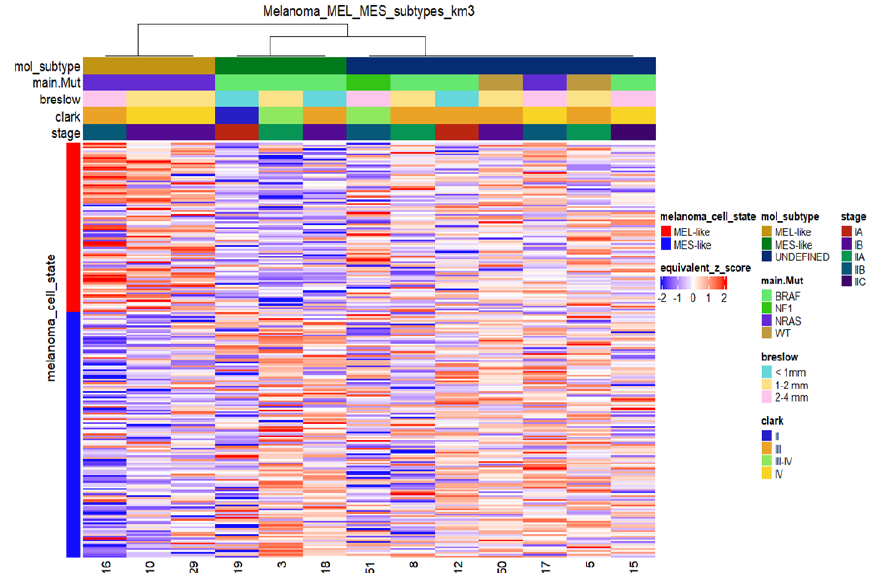
Figure 6. Heatmap of relative mRNA expression of MEL-like and MES-like associated genes in melanoma samples ( n = 13) with sample cluster assignments by k-means clustering. K-means in columns (melanoma cases) identified three distinct groups based on the expression profile of the MEL-like (red vertical bar on the left) and MES-like gene sets (blue vertical bar on the left). Gene expression values were z-transformed and are coloured red for high expression and blue for low expression, as indicated in the scale bar. Clinical (Breslow; Clark and stage) and molecular information (mutated driver genes) of samples is added at the top as colour bars.